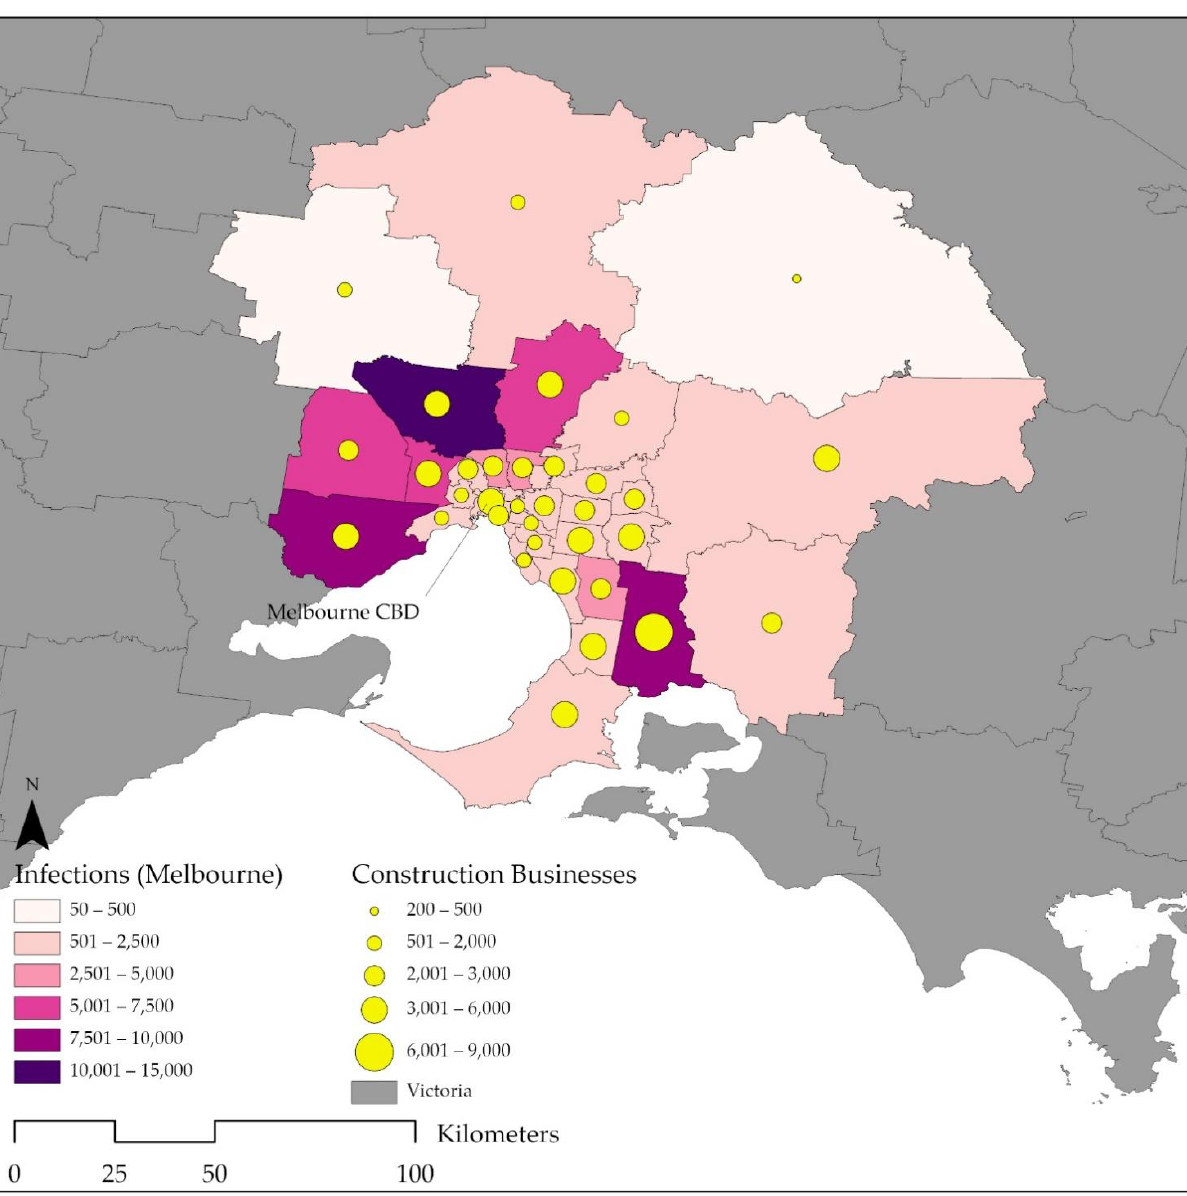
Figure 12. Choropleth map showing COVID-19 cases overlayed by graded symbology showing construction business counts across Melbourne.